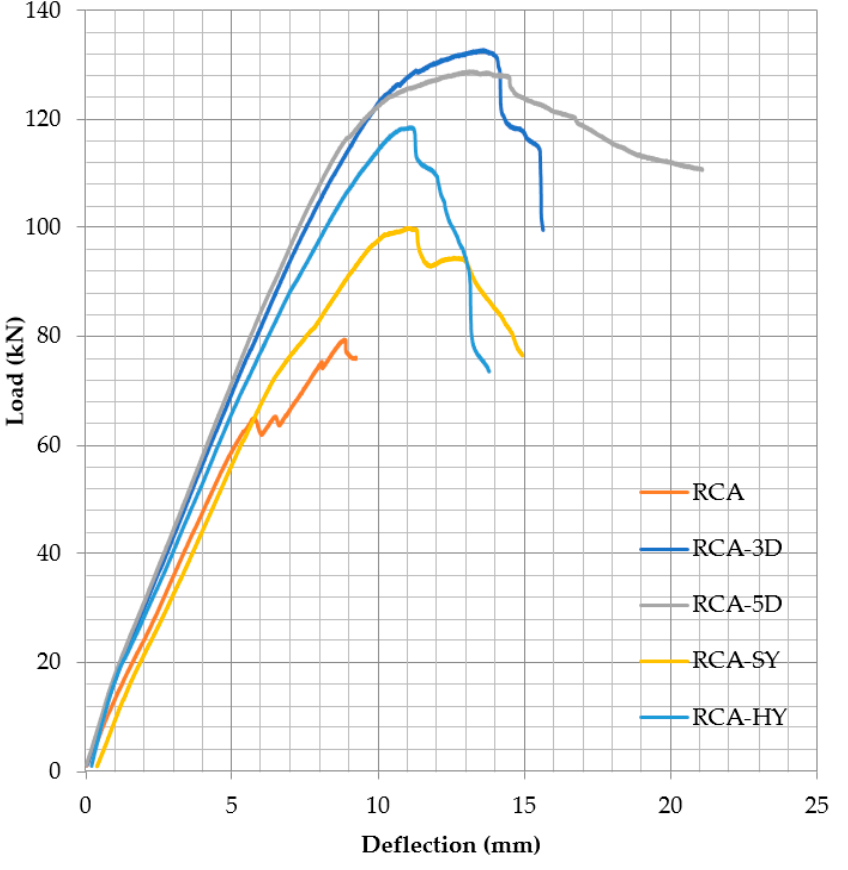
Figure 11. Load-deflection—average results for beams from each mix.